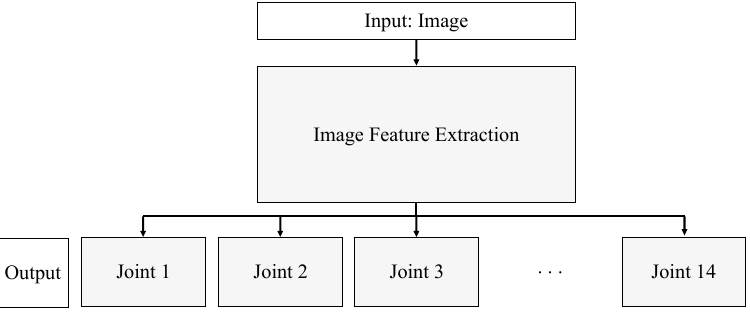
Figure 2. Structure of the preceding model.